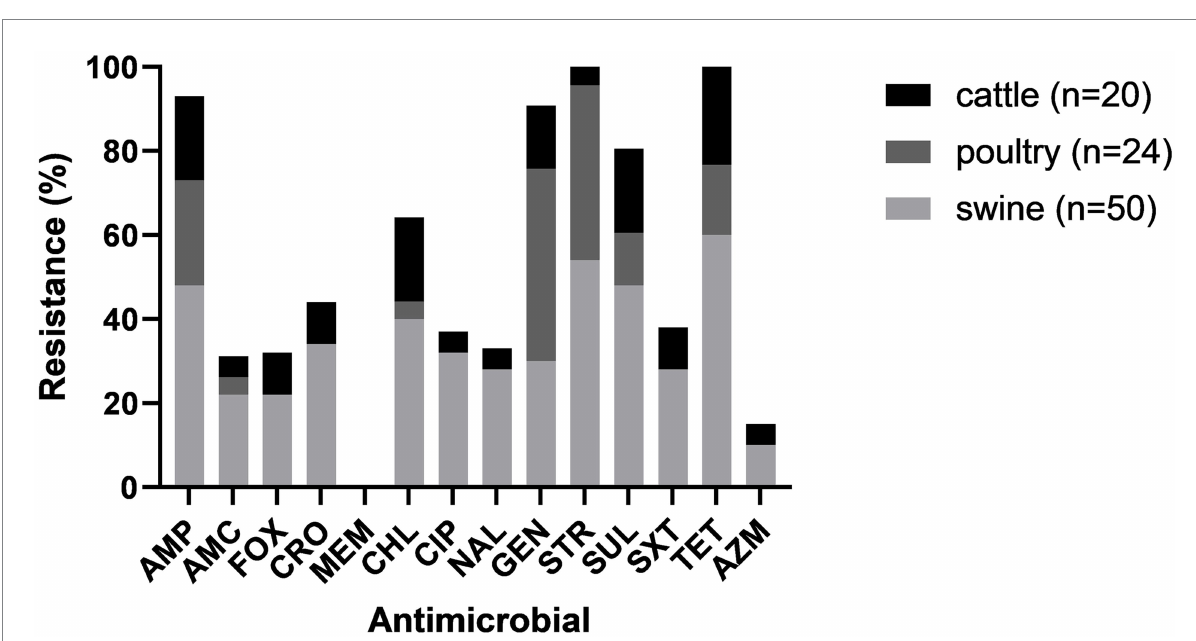
FIGURE 2 Antimicrobial resistance for each drug among cattle, poultry and